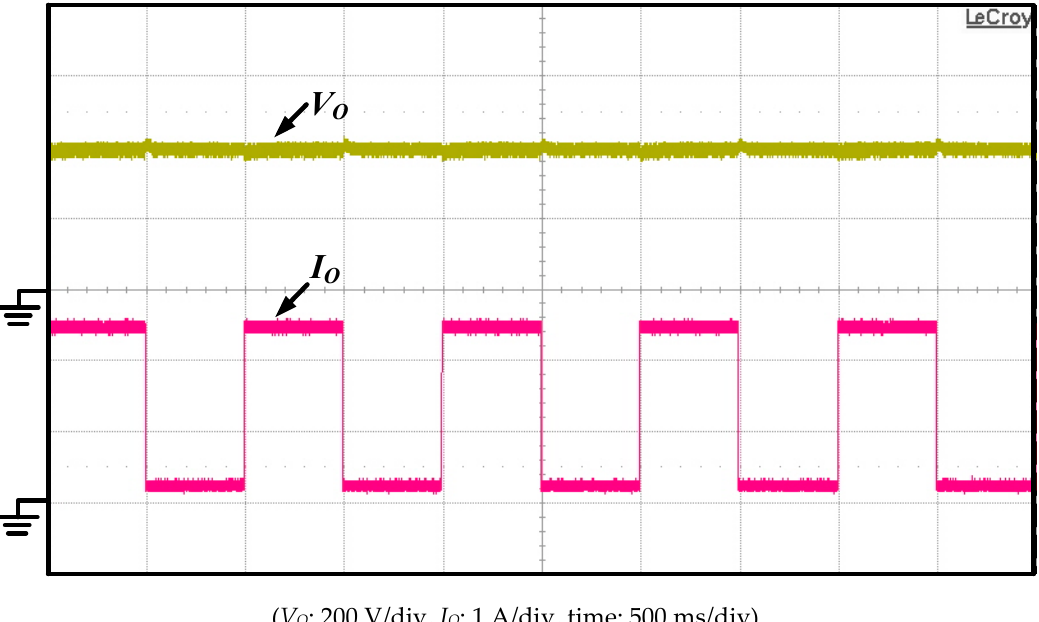
Figure 10. Measured currents i L1 and i L2 and i in waveforms of the proposed interleaving boost converter with ( a ) 10% of full-load condition, and ( b ) 100% of full-load condition under AC 90V of input voltage.